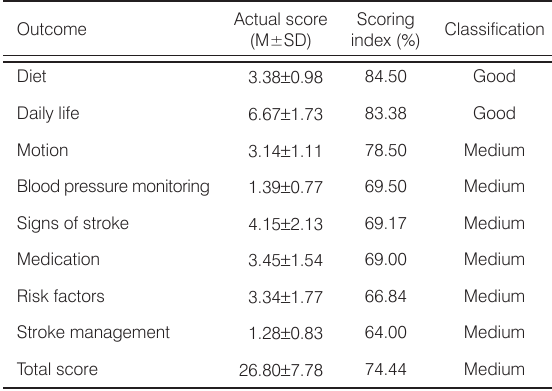
Table 4. Stroke prevention and treatment knowledge score in the stroke recovery stage ( n =440).